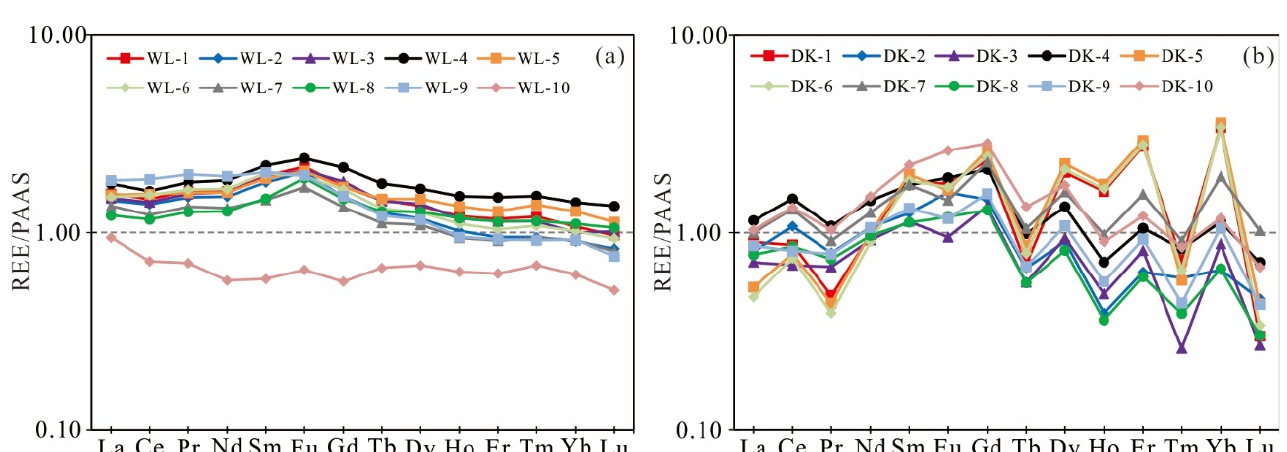
Figure 4. Ternary diagrams showing the relative distribution of Ni-Co-Zn [58].